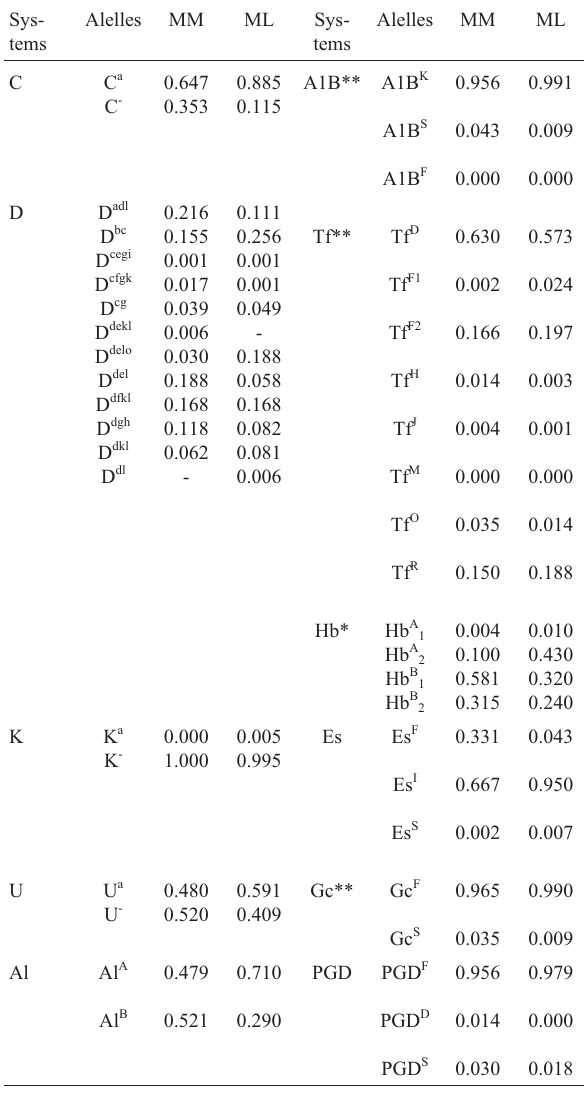
Table 1 - Allelic frequencies of blood groups (C, D, K, P, and U) and biochemical polymorphism loci in Mangalarga Marchador (MM) and Mangalarga (ML)